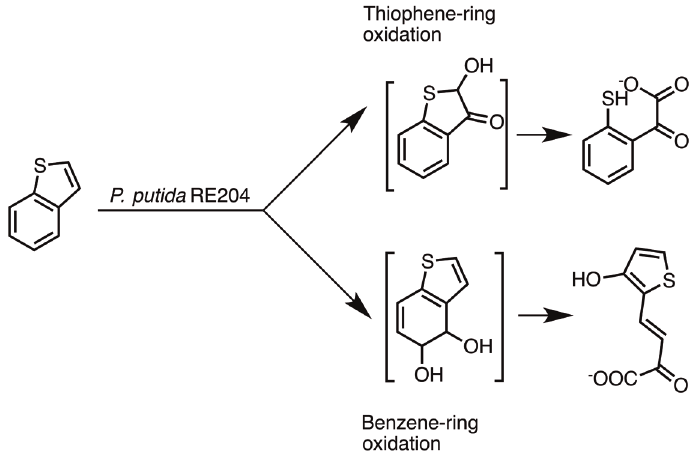
Figure 23 - Oxidation of benzothiophene with Pseudomonas putida